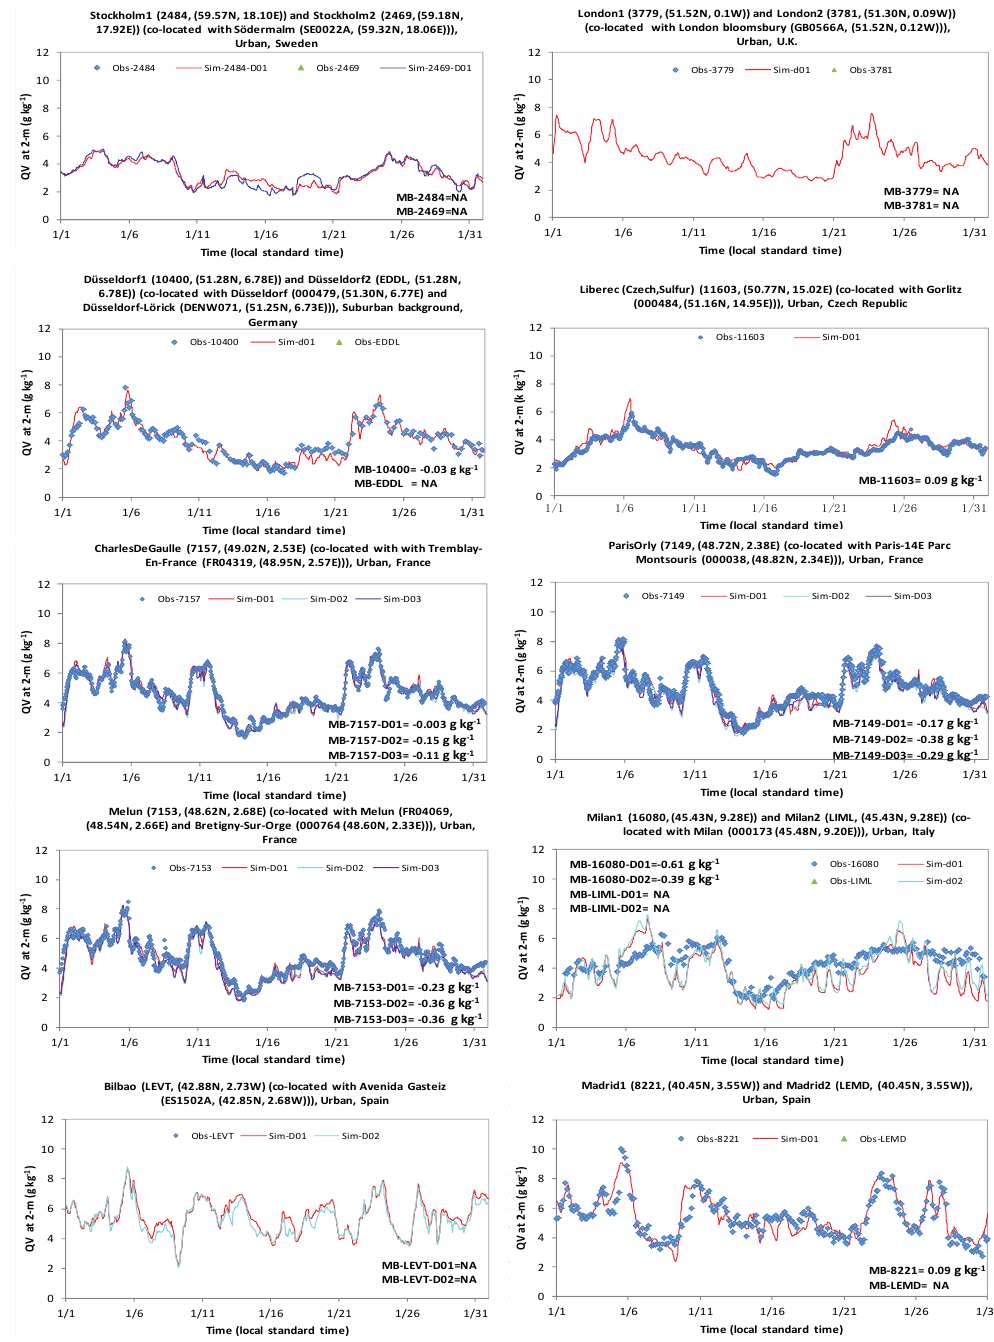
Figure 10. Simulated and observed 2-m specific humidity in January 2001 at selected sites. Statistics are not available (NA) at a few sites where observations were not available. Fig. 10. Simulated and observed 2m specific humidity in January 2001 at selected sites. Statistics is not available (NA) at a few sites where observations were not